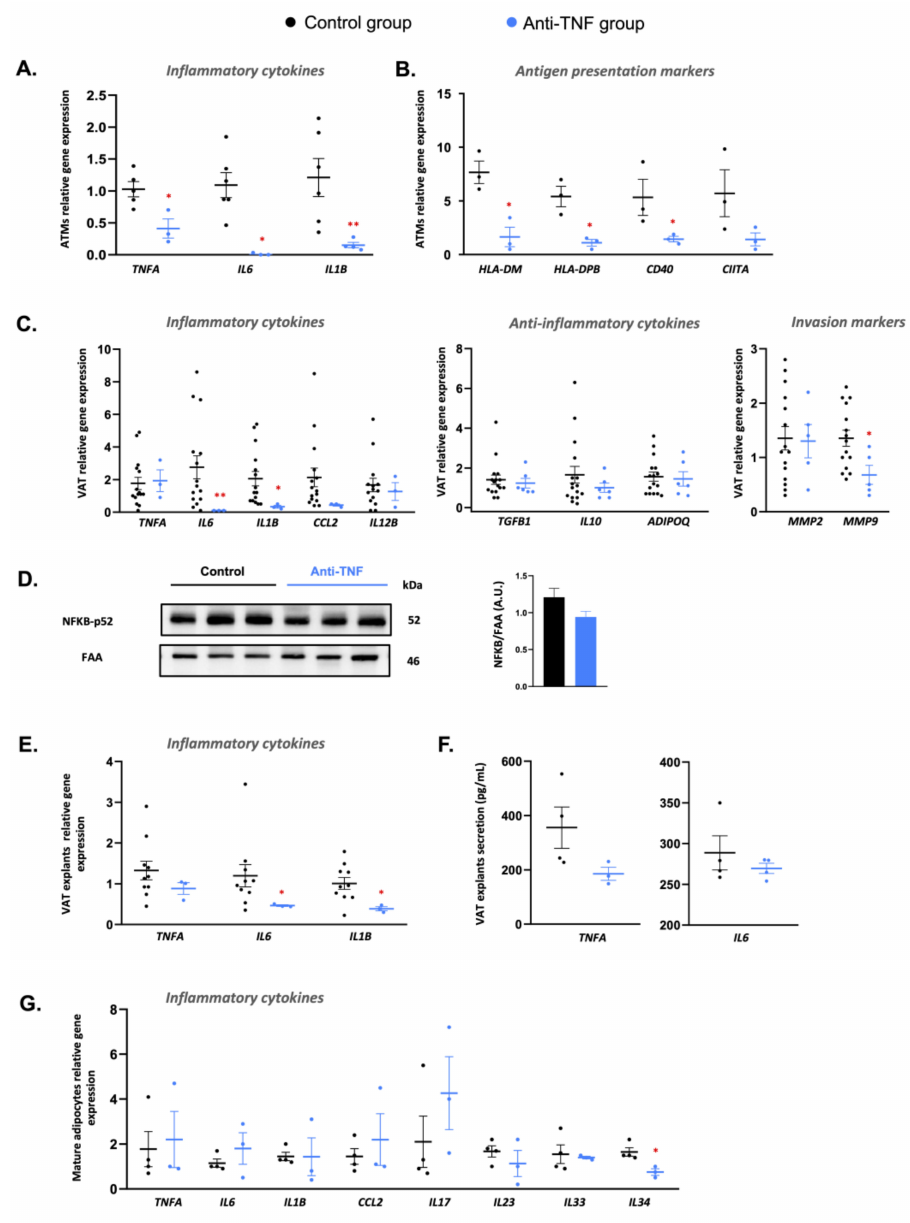
Figure 2. Anti-TNF treatment suppresses inflammation in different cell subtypes of creeping fat. ( A ) Gene expression of pro-inflammatory genes ( TNFA , IL6 , and IL1B ) in VAT-derived adipose tissue macrophages (ATMs). ( B ) Gene expression of antigen-presentation markers in VAT-derived ATMs. ( C ) Gene expression of the inflammatory cytokines TNFA, IL6 , IL1B, CCL2, and IL12B; anti-inflammatory cytokines TGFB1 , IL10 , and ADIPOQ ; the invasion markers MMP2 and MMP9 in the creeping fat of patients treated with anti-TNF or control group. ( D ) NFKB-p52 protein expression analyzed by Western blotting in the creeping fat of patients treated with anti-TNF or control group ( E ) Gene expression of the pro-inflammatory cytokines TNFA , IL6 , and IL1B in VAT explants isolated from patients treated with anti-TNF or control group. ( F ) TNFA and IL6 abundance in 24 h conditioned medium of VAT explants from patients treated with anti-TNF or control group. ( G ) Inflammatory cytokine gene expression in mature adipocytes isolated from patients treated with anti-TNF or control group. Results are shown as mean ± SEM from independent donors’ experiments. * p < 0.05 and ** p < 0.01 vs. control